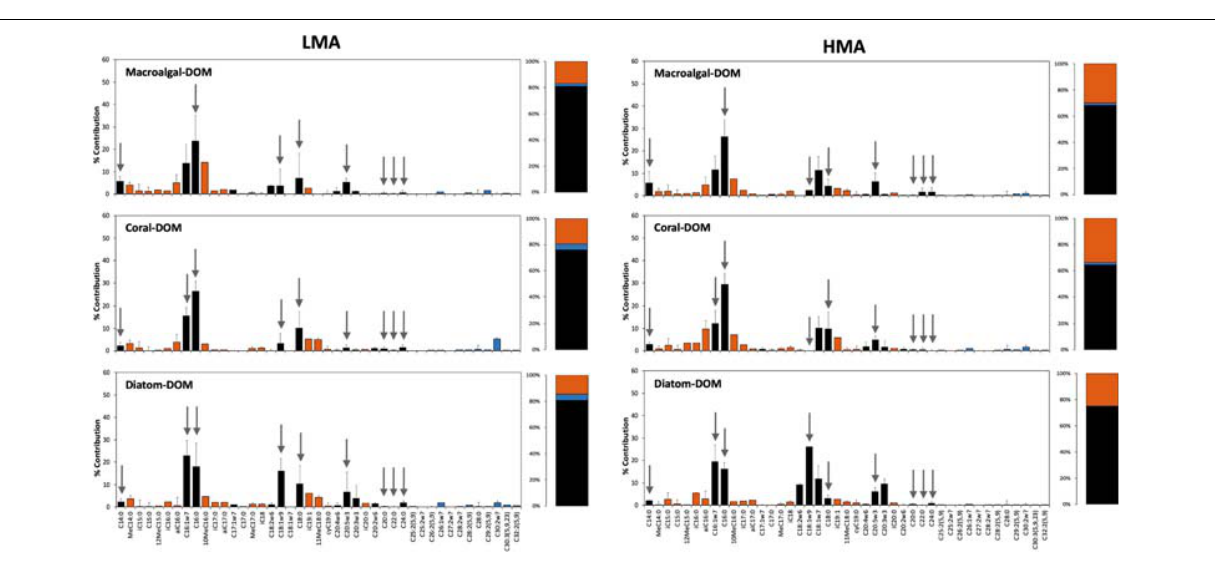
FIGURE 4 | Assimilation of tracer DOM sources into phospholipid fatty acids (PLFAs). Incorporation of tracer DOM into bacteria- (red), sponge-specific (blue), and other (black) PLFAs. LMA species on the left-hand side and HMA species on the right-hand side; upper row sponges were fed with macroalgal-DOM, central row with coral-DOM and lower row with diatom-DOM. Gray arrows indicate PLFAs that were also present in the source (direct uptake), all other PLFAs are de novo synthesized. Values depicted as the percentage contribution to the total DOC incorporation for each individual PLFA. Stacked barplots depict the total percentages of bacterial, sponge and other PLFAs. Data presented as mean (%) ± SD ( n = 3